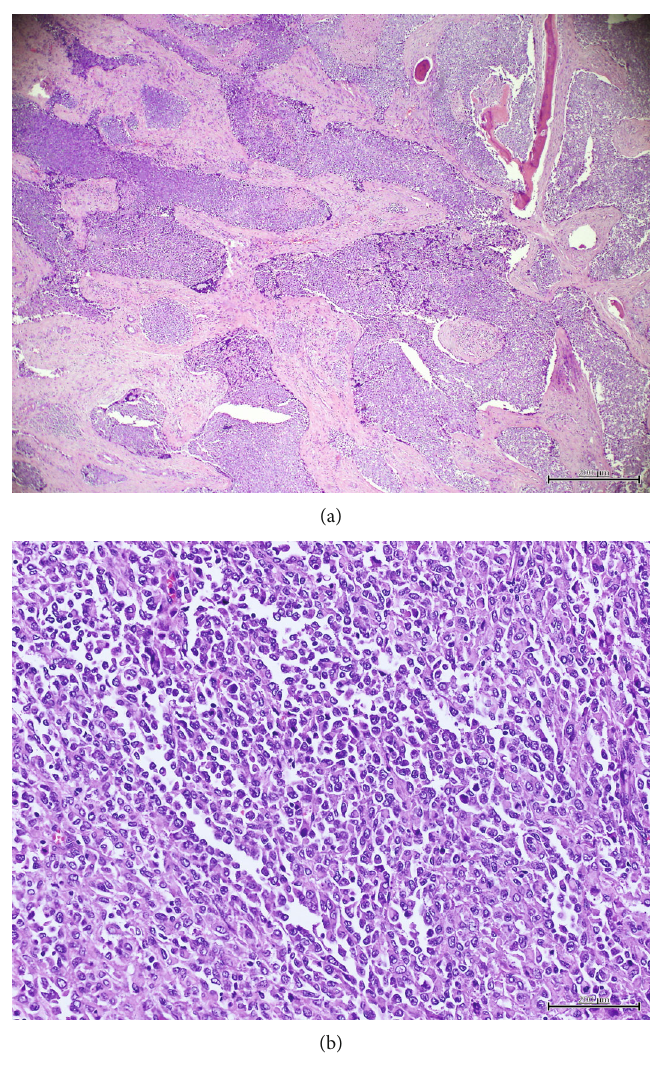
Figure 2: (a) Low magni fi cation shows anastomosing sheets of in fi ltrating neoplasm arranged in lobules with central necrosis (hematoxylin- eosin stain, original magni fi cation × 40). (b) High magni fi cation shows rhabdoid morphology and brisk mitosis (hematoxylin-eosin stain, original magni fi cation ×